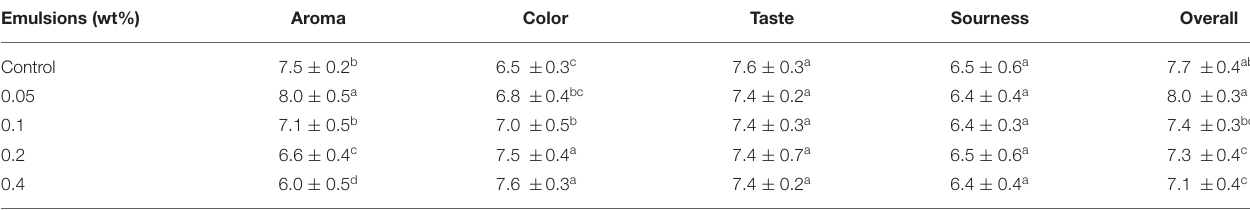
TABLE 3 | Effect on the organoleptic characteristics of the pineapple juices treated under galangal essential oil emulsion. Emulsions